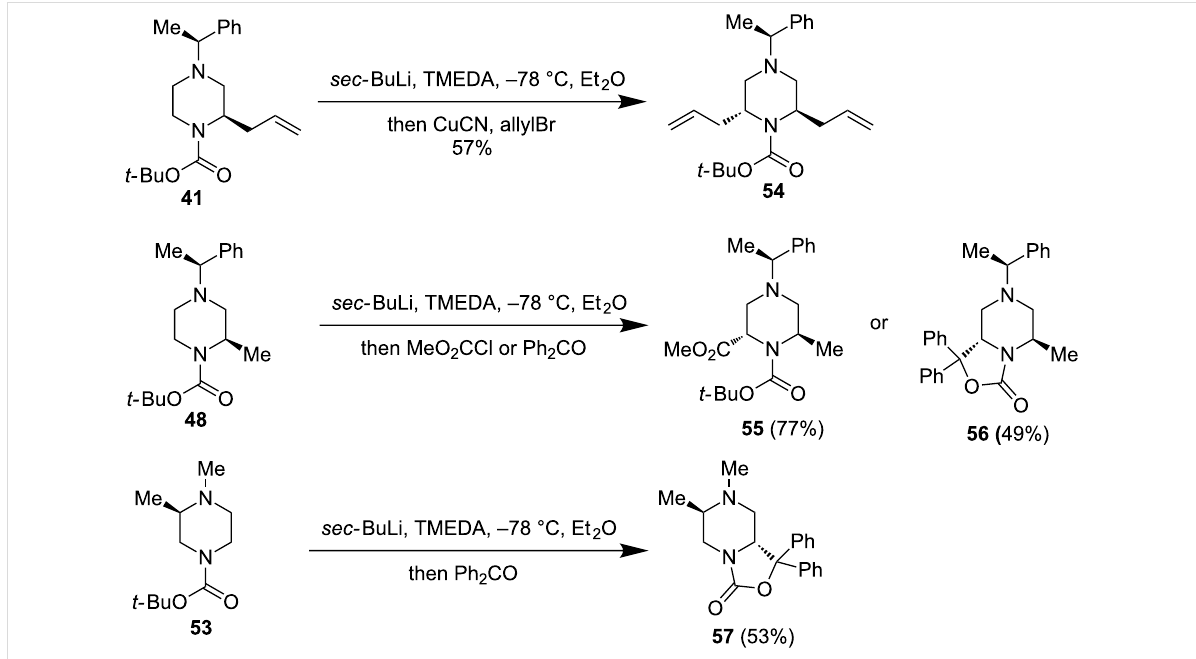
Figure 12: α -Lithiation trapping of C -substituted N -Boc-piperazines by O’Brien et al. 2016 [43].